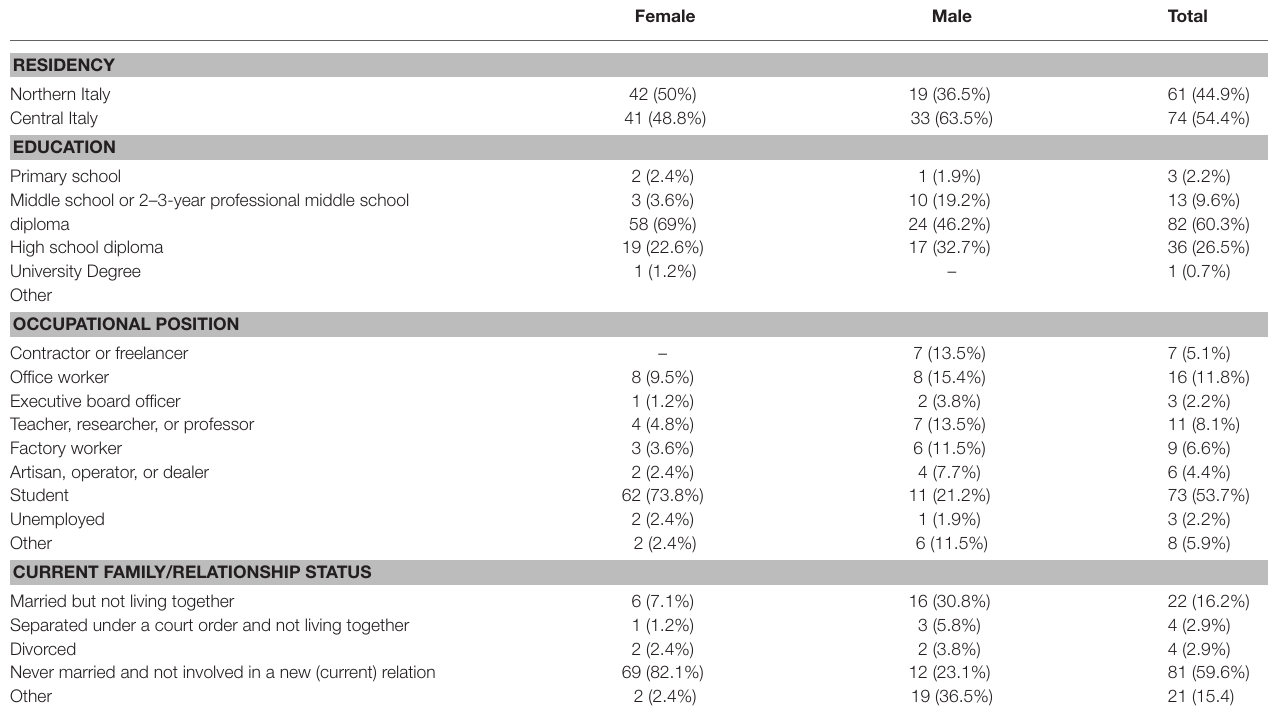
TABLE 1 | Sociodemographic characteristics of the sample ( N =